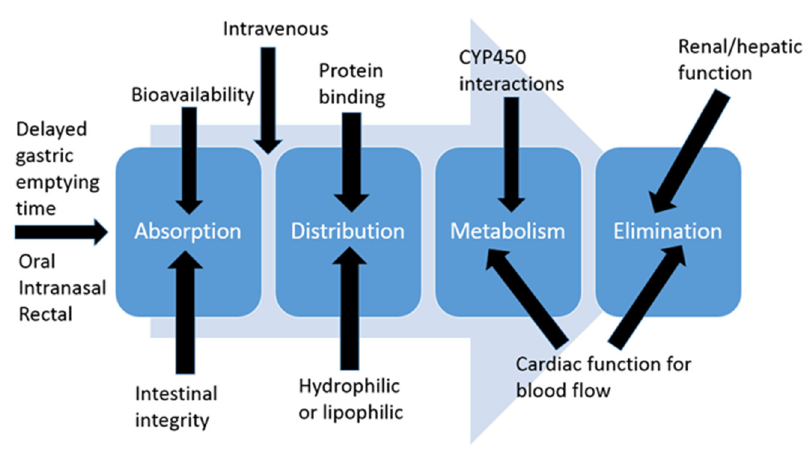
Figure 1. Absorption, distribution, metabolism, and elimination (ADME) overview.